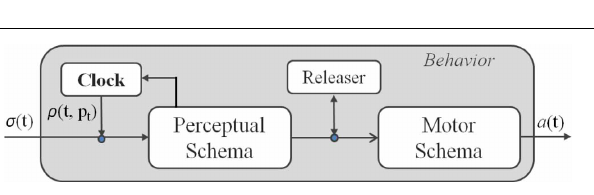
FIGURE 2 | Schema Theory representation of an attentional